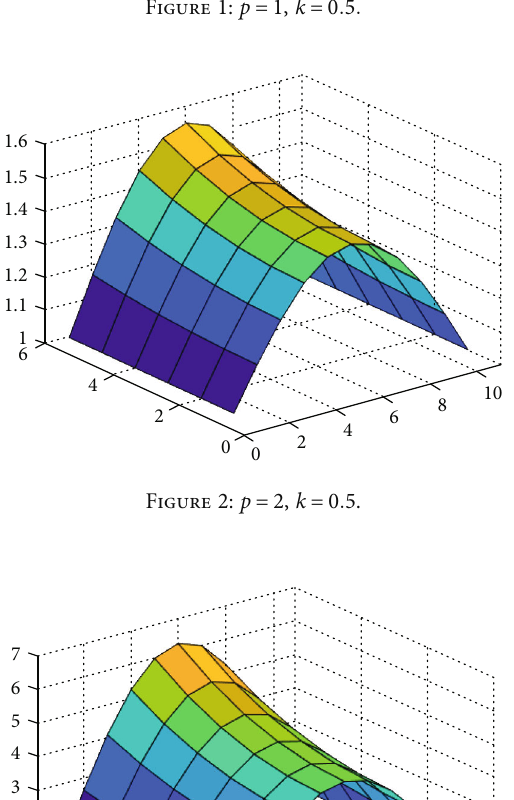
Figure 4: p = 2 , k = 1 .